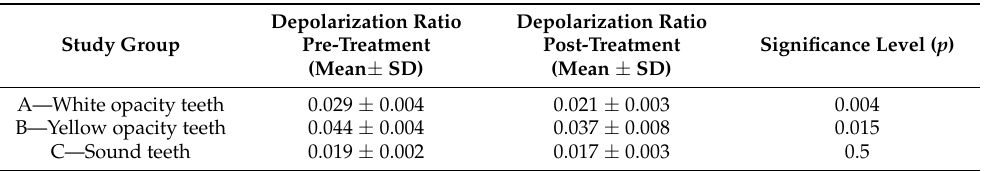
Table 1. Mean depolarization ratio and standard deviations (SD) of the symmetric stretching band of phosphate values for the three